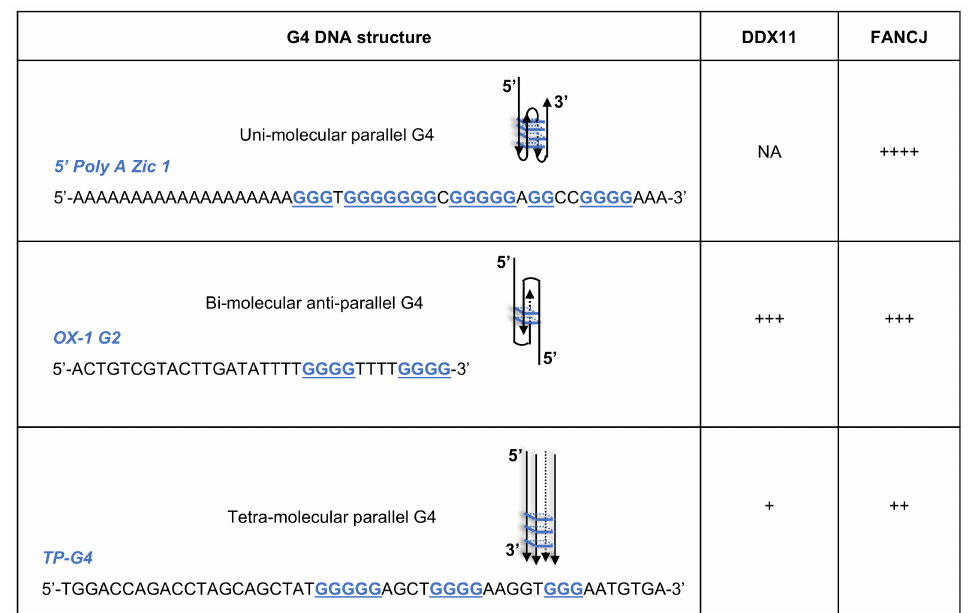
Figure 2. Specificity of DDX11 and FANCJ DNA helicases towards a set of G4-containing DNA substrates, whose structure is schematically depicted. The sequence of the corresponding synthetic oligonucleotides is also reported. Guanine residues forming the stacked G-quartets (colored in blue in the drawings) are highlighted in bold and in blue and underlined. Different catalytic efficiency of DDX11 and FANCJ in resolving the G4 DNA substrates is roughly indicated by a variable number of + , according to previous reports [6,7]. NA: not